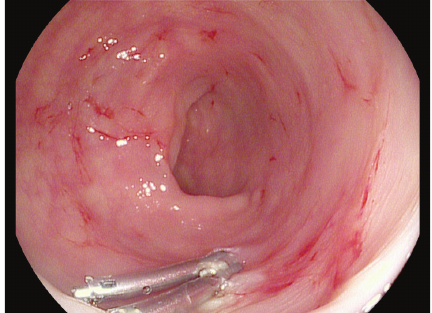
Figure 1: Presence of active oozing blood from transverse colonic Dieulafoy’s lesion. Arrow indicates source of bleeding.